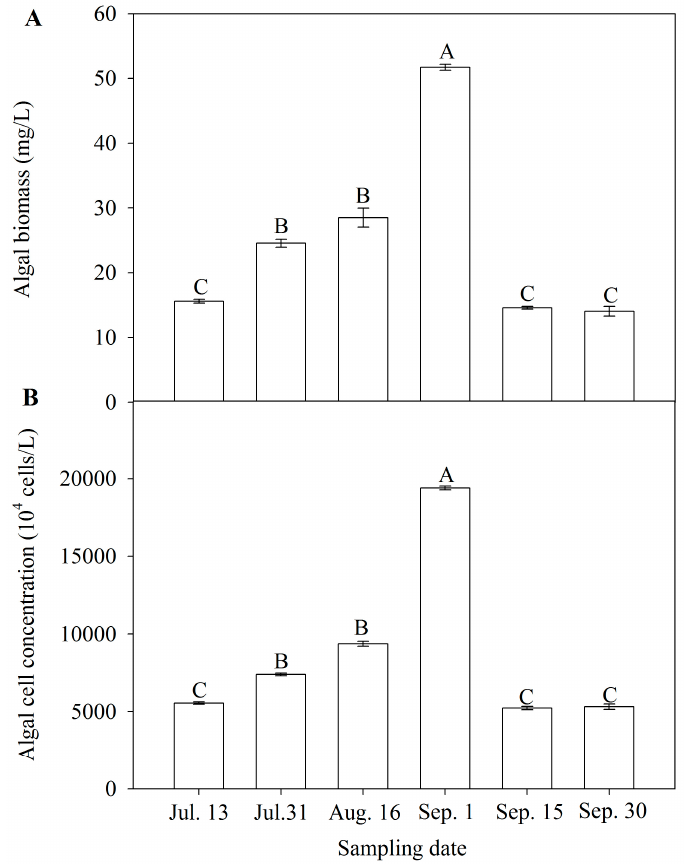
Figure 1. Algal biomass ( A ) and algal cell concentration ( B ) in Zhoucun drinking water reservoir during algal bloom outbreak and decline from July to September, 2012. Bars with different upper letter are significantly different at 0.01 levels. Error bars represent standard deviations ( n = 3).